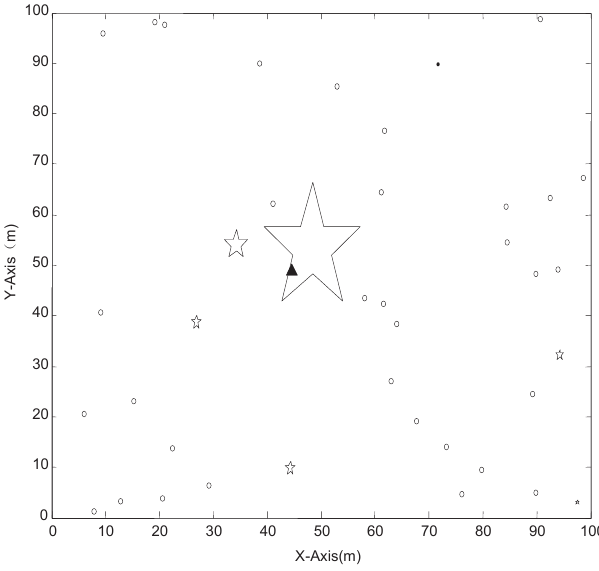
Figure 4. The example for the validity of the